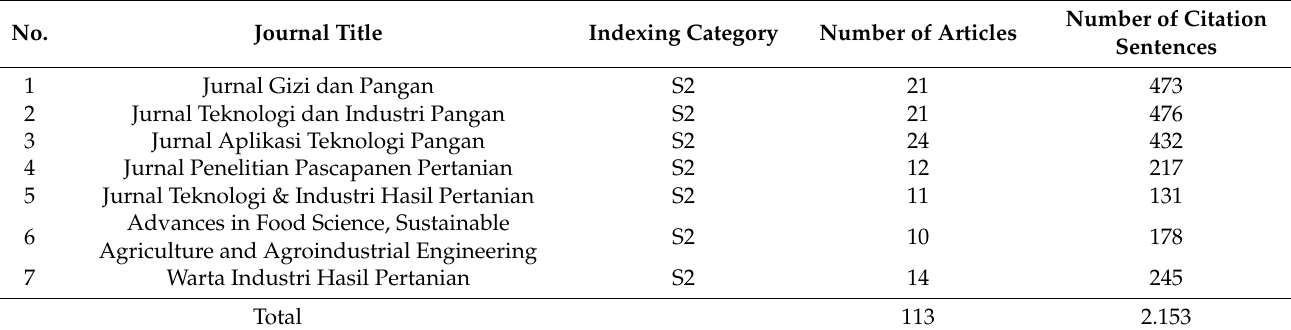
Table 1. The scope and statistics of the dataset.